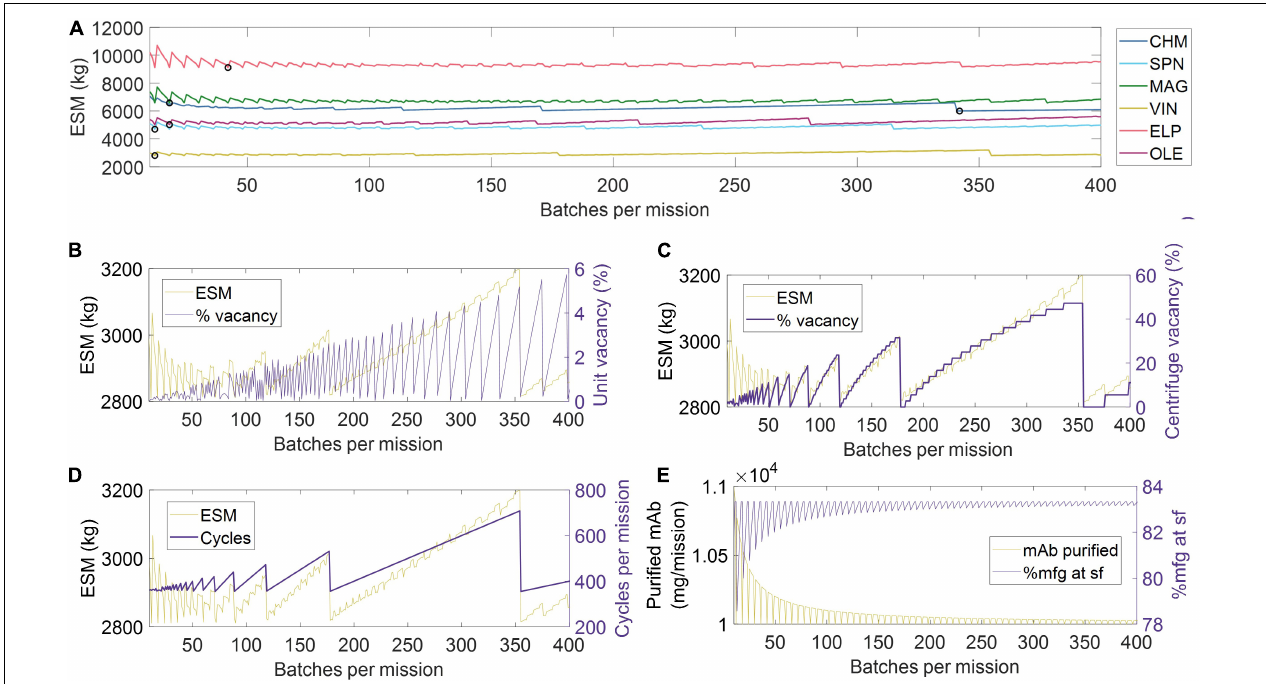
FIGURE 3 | (A) Scheduling optimization for the establishment of base case scenarios for each unit procedure. The value for number of batches corresponding to the minimum equivalent system mass for each unit procedure, as indicated by black circle ( ◦ ) markers. Key operational parameters impacted by mission scheduling (shown using the VIN procedure) include (B) unit underutilization or vacancy, (C) equipment underutilization or vacancy, in this case represented by the centrifuge as the bottleneck, (D) the number of use cycles, and (E) the total quantity of monoclonal antibody (mAb) per mission and per surface operation (sf). CHM, pre-packed chromatography; SPN, spin column; MAG, magnetic bead; VIN, plant virus-based nanoparticle; ELP, elastin-like polypeptide; OLE,